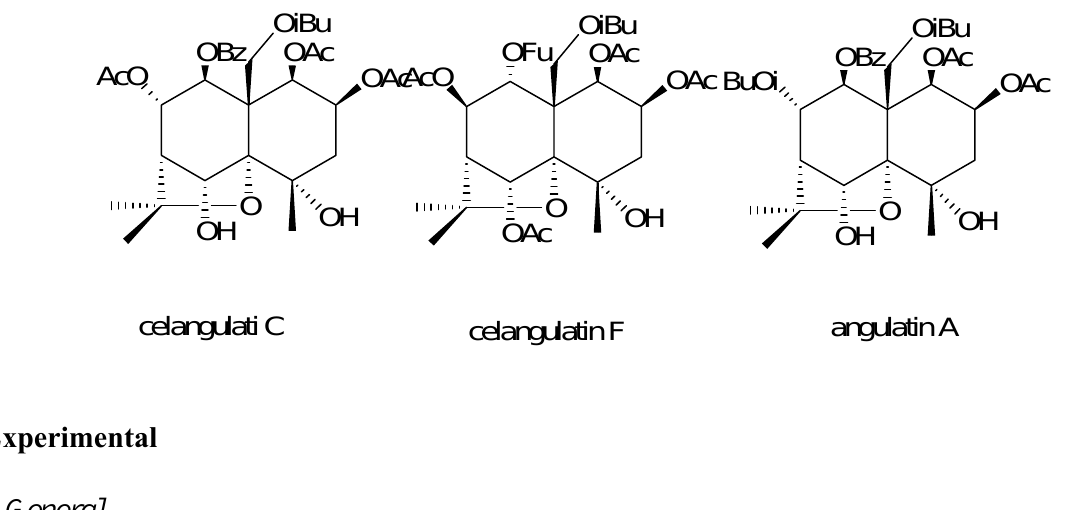
Figure 3. The structures of celangulatin C, celangulatin F and angulatin